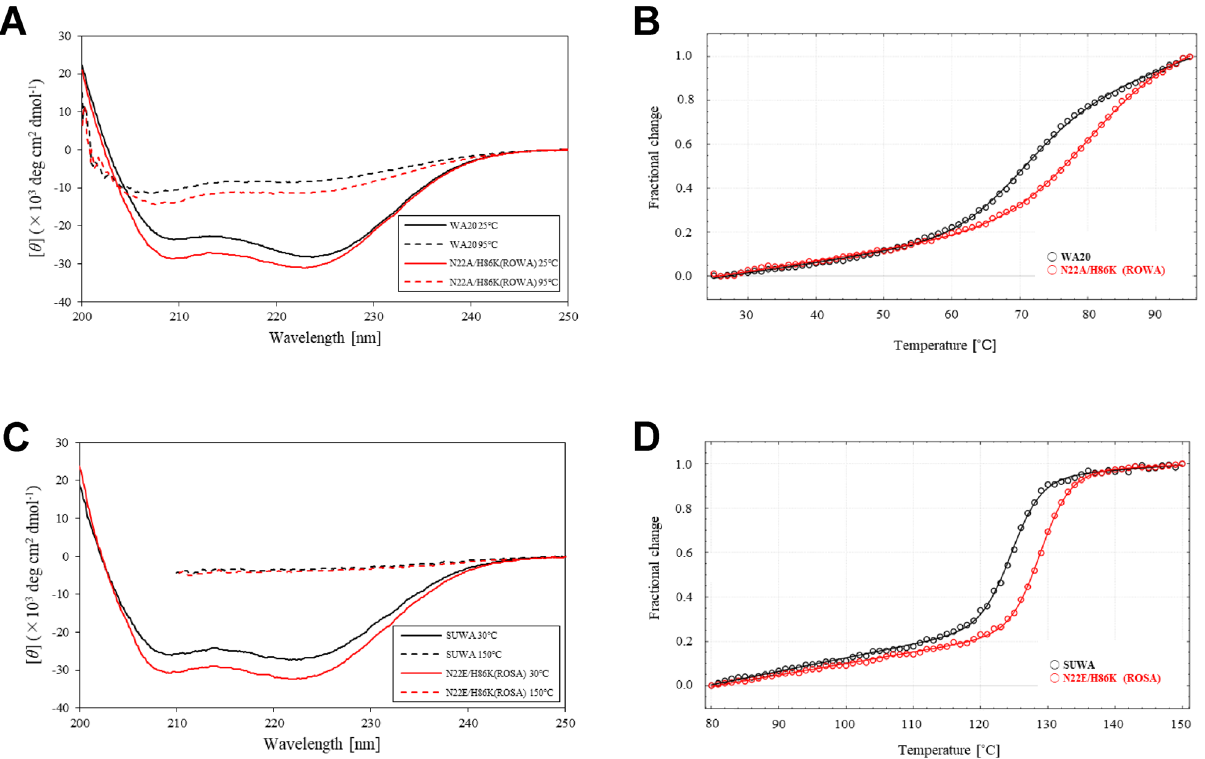
Figure 2. CD spectra and thermal denaturation curves. ( A ) CD spectra of WA20 and the N22A/H86K mutant of WA20 (ROWA) at 25 and 95 °C. ( B ) Thermal denaturation curves of WA20 and ROWA. The T m values of the WA20 and ROWA proteins are 69.8 ± 0.4 and 80.4 ± 3.5 °C, respectively. ( C ) CD spectra of SUWA and the N22E/ H86K mutant of SUWA (ROSA) at 30 and 150 °C. ( D ) Thermal denaturation curves of SUWA and ROSA. The T m values of SUWA and ROSA are 124.7 ± 0.1 and 129.0 ± 0.1 °C, respectively. In the denaturation curves, the Y- axis represents the normalised value of [ θ ] 222 nm . The data of the denaturation curves were fitted to a two-state model with Δ C p fixed to zero and the graphs were created using CDpal 33 , version 2.18 (https:// github. com/ PINT- NMR/ CDpal/).